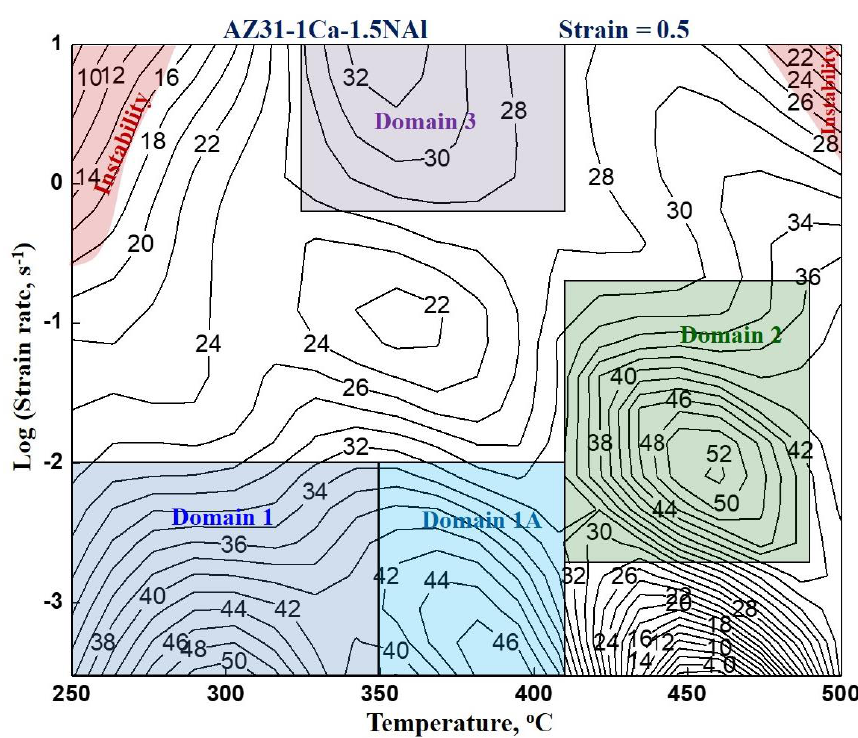
Figure 4. Processing map for DMD-processed AZ31-1Ca-1.5NAl composite at a strain of 0.5. The numbers associated with the contours indicate efficiency of power dissipation in percent. Reproduced with permission from [12], Elsevier, 2015.